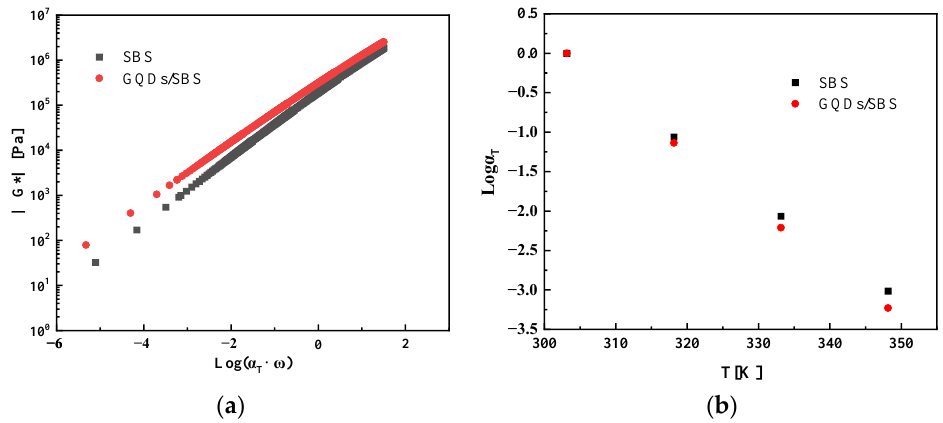
Figure 7. ( a ) Master curves for GQDs/SBS composite-modified asphalt and SBS-modified asphalt at the reference temperature of 30 °C and ( b ) Variations of the translocation factor with temperature.